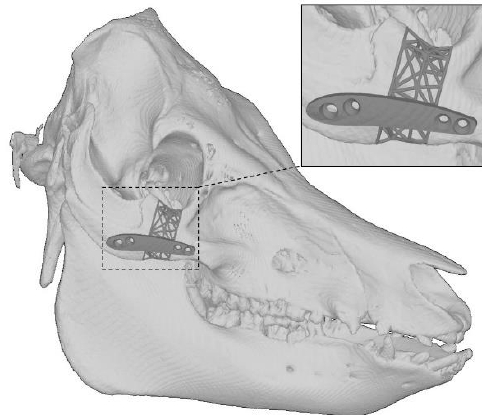
Figure 6. The computer-aided design (CAD) implant attached to the segmental resection of the zygomatic bone.